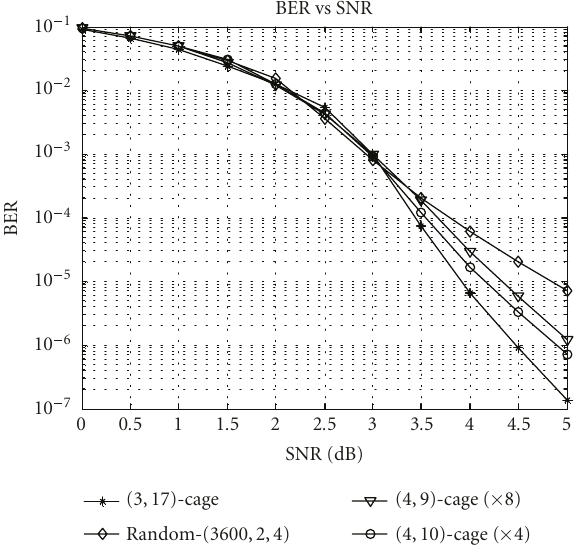
Figure 2: BER performances of high girth LDPC codes from dis- tance graphs (25